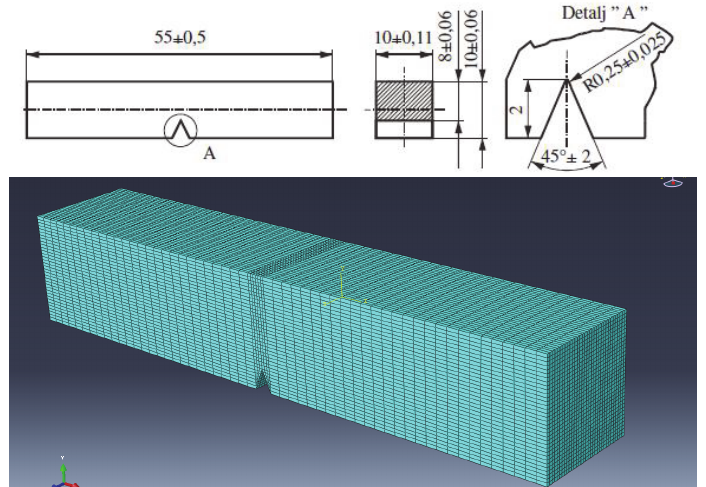
Figure 1: Standard Charpy specimen: dimensions of the specimen and 3D model obtained using Abaqus